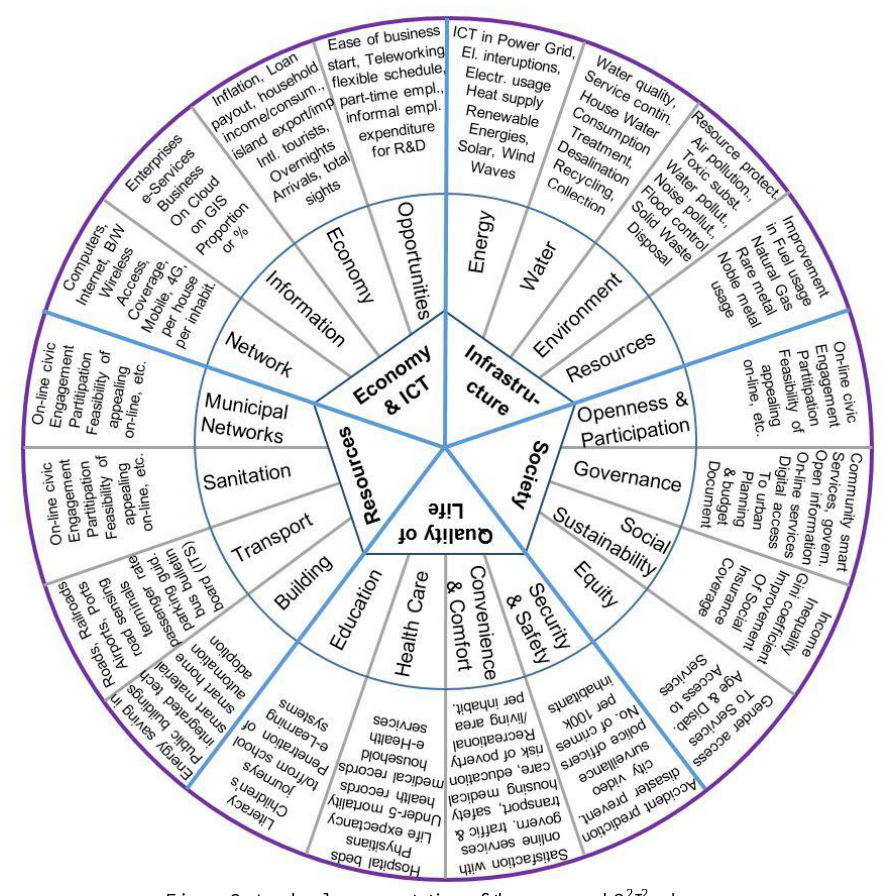
Figure 2: A wheel representation of the proposed S 2 I 2 scheme.